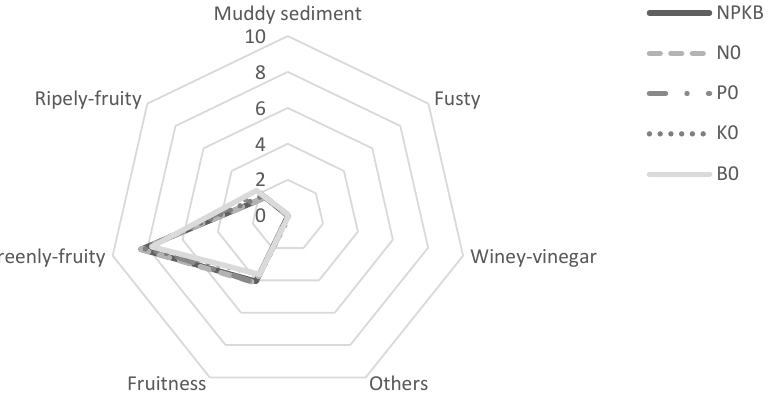
Figure 5. Sensory profiles of virgin olive oils obtained from olive trees supplied with NPKB (control) and without N (N0), P (P0), K (K0) and B (B0) in the harvest of 2018.